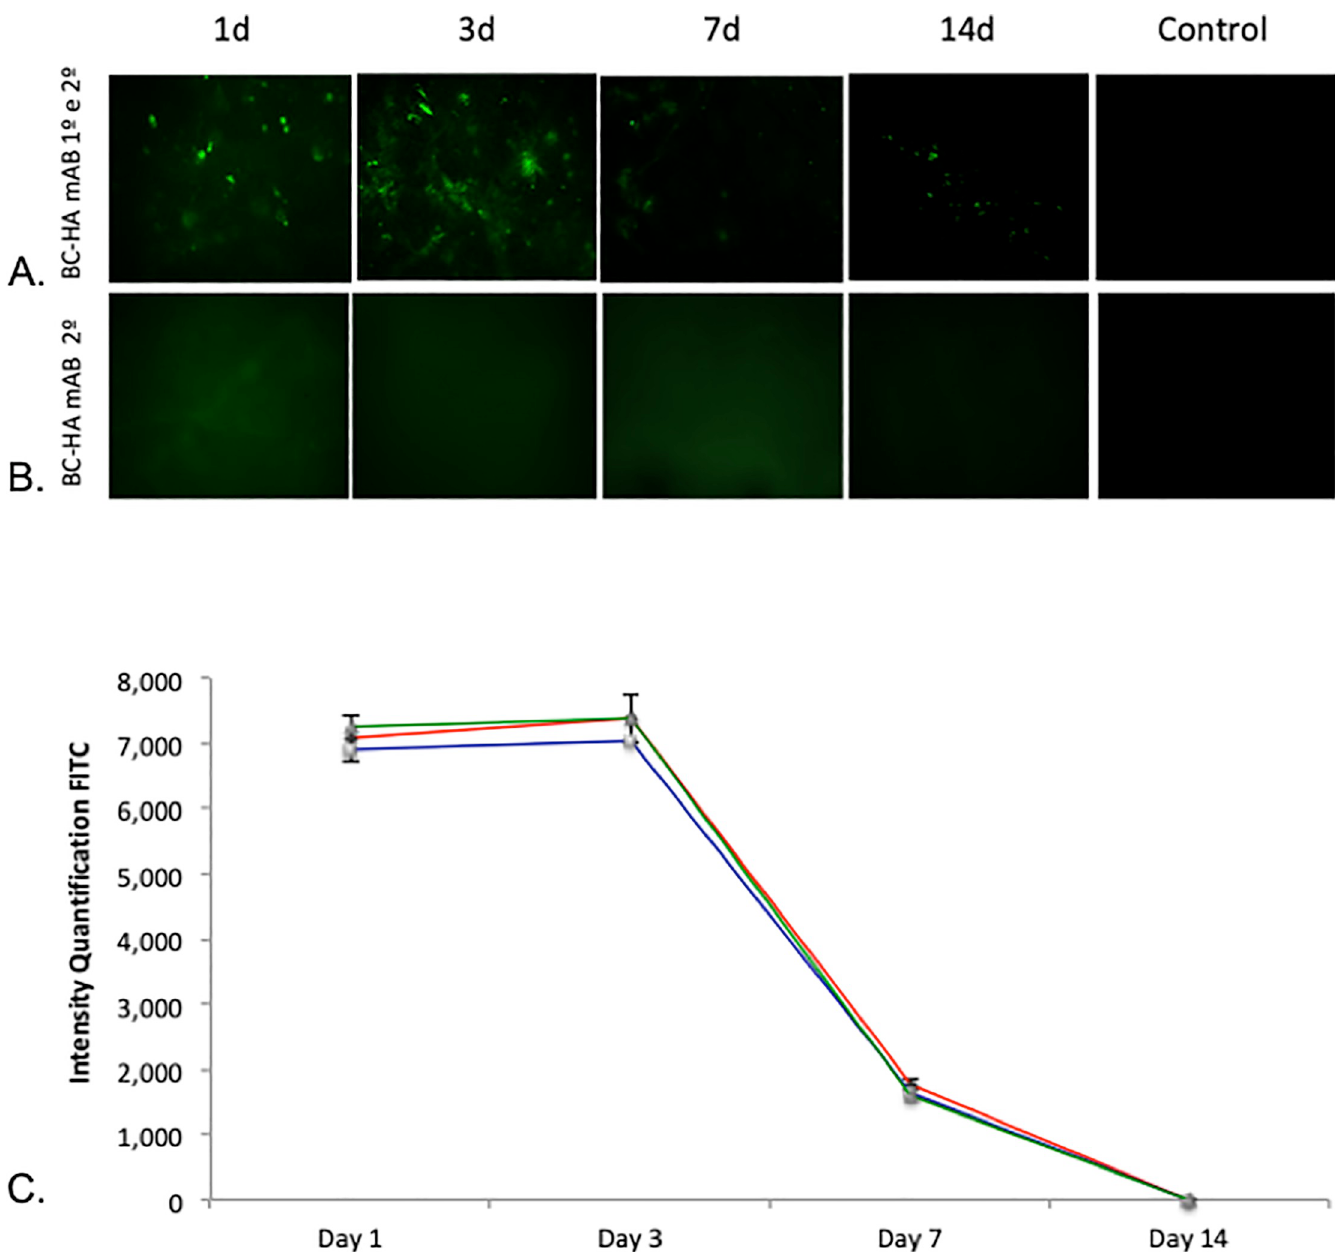
Fig 6. Characterization of the in vitro adsorption profile of BMP-2 on BC membranes. Anti-BMP-2 adsorption on BC-HA was evaluated by incubation with FITC- conjugated anti-mouse IgG2a at different times (1, 3, 7, and 14 days). (B) BC-HA incubated with FITC-conjugated anti-mouse IgG2a at different times (1, 3, 7, and 14 days). The Control column is represented by membranes incubated with secondary antibody alone. (C) Quantification of FITC intensity was performed by ImageJ software (NIH, Bethesda, MD, USA). The results from one experiment are presented.